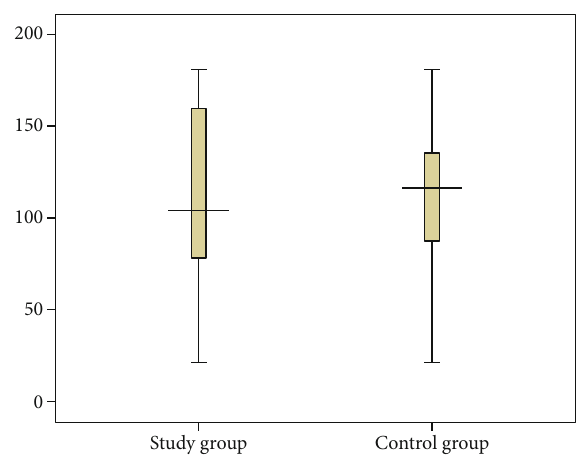
Figure 1: The box-plot distribution and comparative analysis of the survival time between overall study group ( n = 133 ) and overall control group ( n = 589 ), and no signi fi cant di ff erence ([95% CI]: -17.05-0.375, t = − 1 : 889 , P value = 0.061). Table 4: Comparison of survival time according to di ff erent characteristics